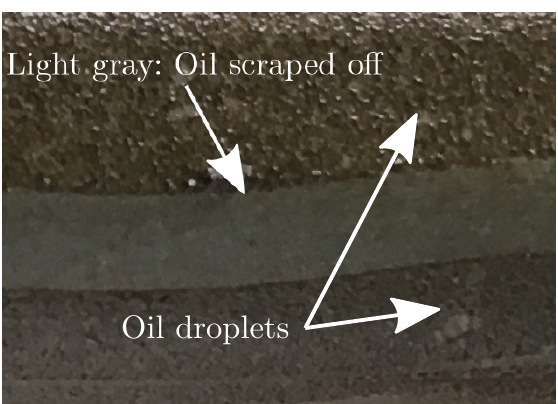
Figure 9. Oil accumulated on the permeate side of the membrane, the light gray color across the membrane is an area where the oil is scraped